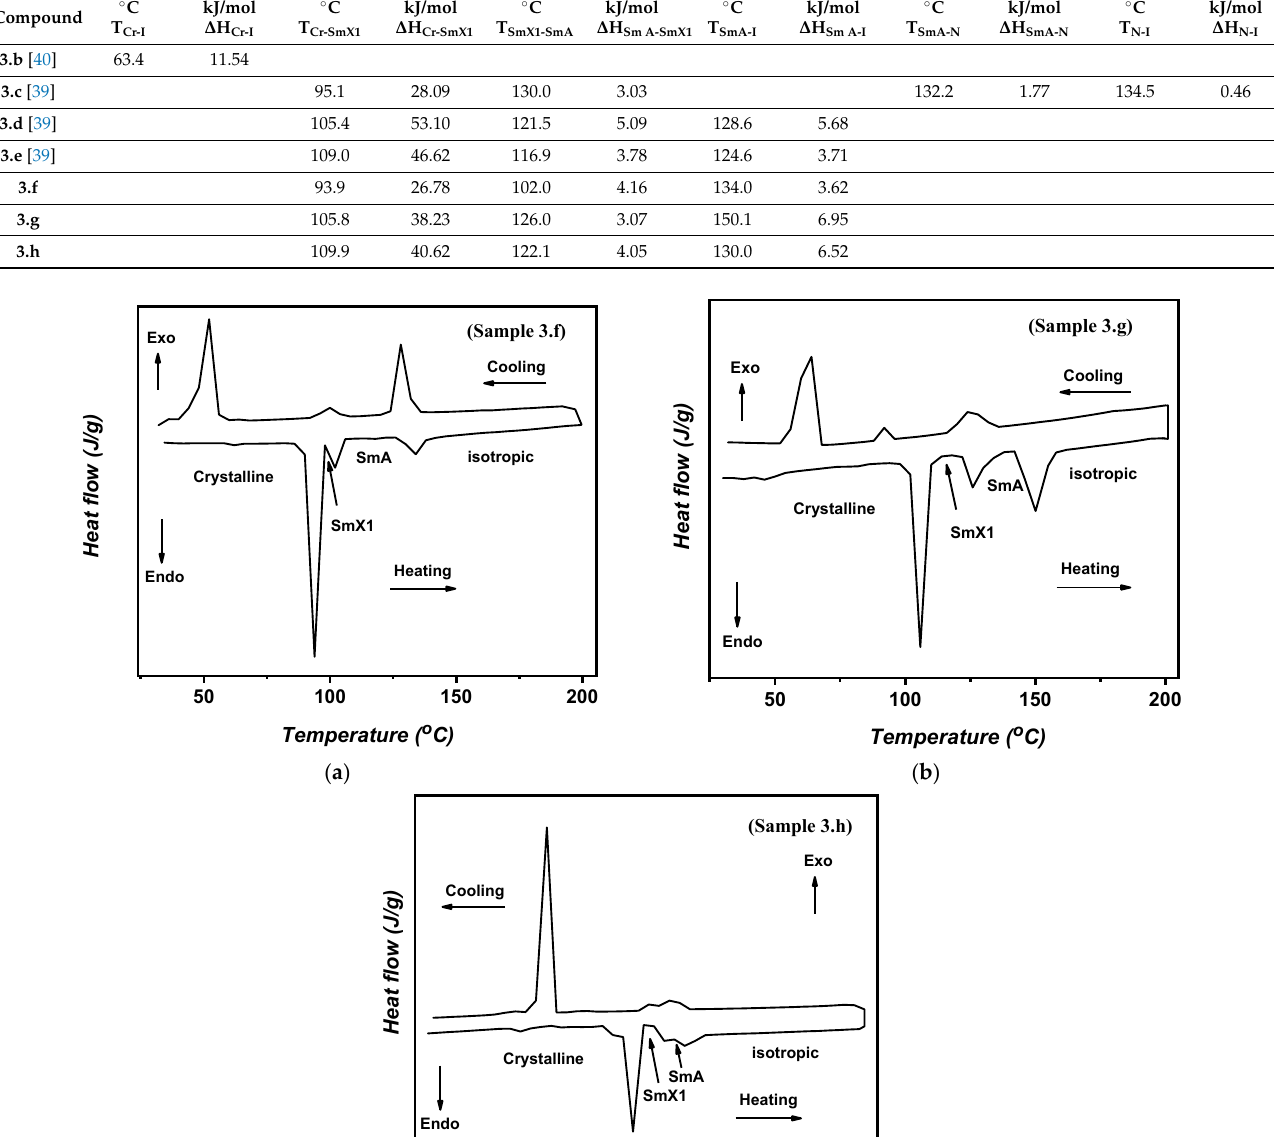
Table 2. Variation of mesophase temperature ranges of the different observed textures for the mesomorphic compounds bearing the biphenyl group rather than 4-phenyl pyridine ends in their mesogens. SmX1 and SmA were identified by the authors in reference number 40 for samples 3.c, 3.d and 3.e as SmX1 and SmA, respectively. Alkyl Chain Length Table 1. Phase transitions: Temperatures ( T , ◦ C), enthalpies ( ∆ H , kJ/mol) and mesomorphic range ( ∆ T ) for the prepared